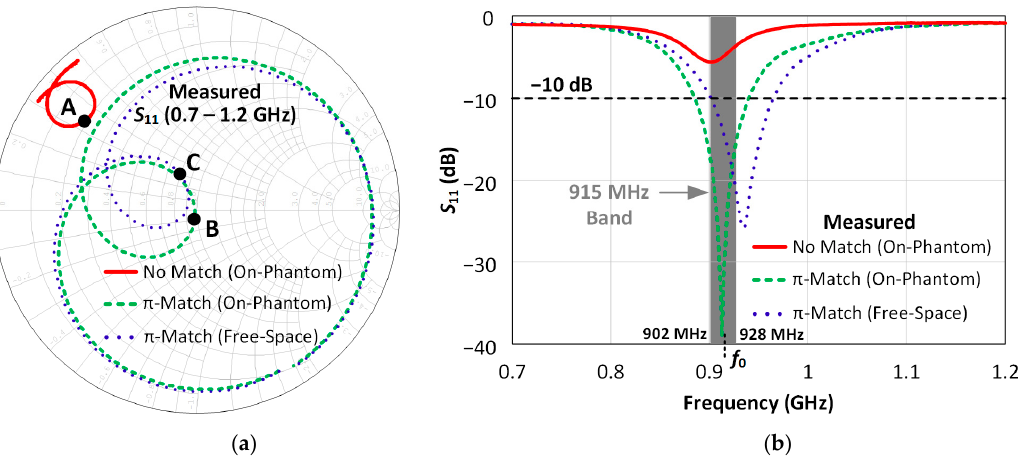
Figure 11. Impedance Matching: ( a ) Smith-Chart plot of the antenna impedance without matching network (solid red line), with the matching network on-phantom (dashed green line) and with the matching network in free-space (dotted blue line); ( b ) |S 11 | plot of the antenna impedance without matching network (solid red line), with the matching network on-phantom (dashed green line) and with the matching network in free-space (dotted blue line).